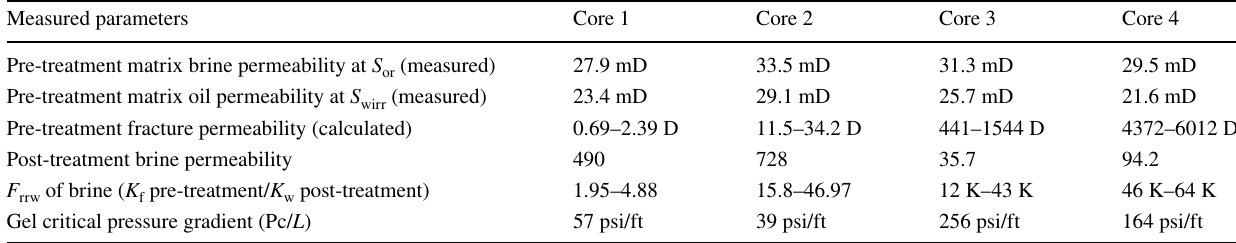
Gel critical pressure gradient (Pc/ L